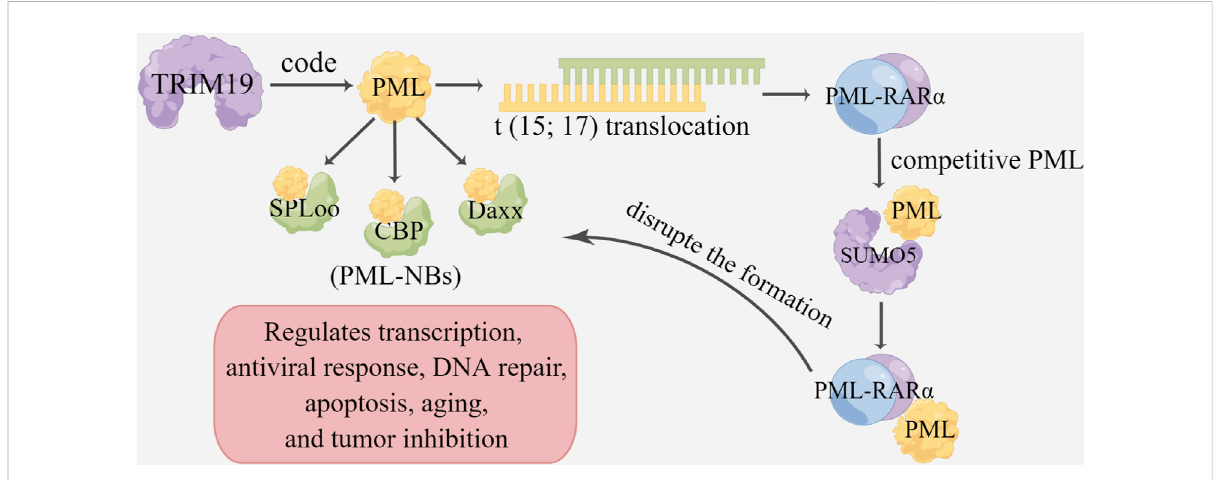
FIGURE 2 TRIMsand chromosome translocation andtranscription.TRIM19isinvolved inencodingpromyelocyticleukemiagenePML,which isfusedinto PML-RAR α and PML-NBS, and plays a role in tumor genesis and development. The promyelocytic leukemia gene (PML) encodes TRIM19, which is characterizedbyitsinvolvementintranslocationT(15;17),resultinginthePML-retinoicacidreceptor- α (RAR α ))fusionprotein.PMLcaninteractwith SPLoo, CBP and Daxx to form PML nuclear bodies (PML-NBSs), which regulate transcription, antiviral response, DNA repair, apoptosis and tumor suppression. PML-RAR α can also competitively bind to PML via SUMO5, thereby disrupting PML-NBS formation.